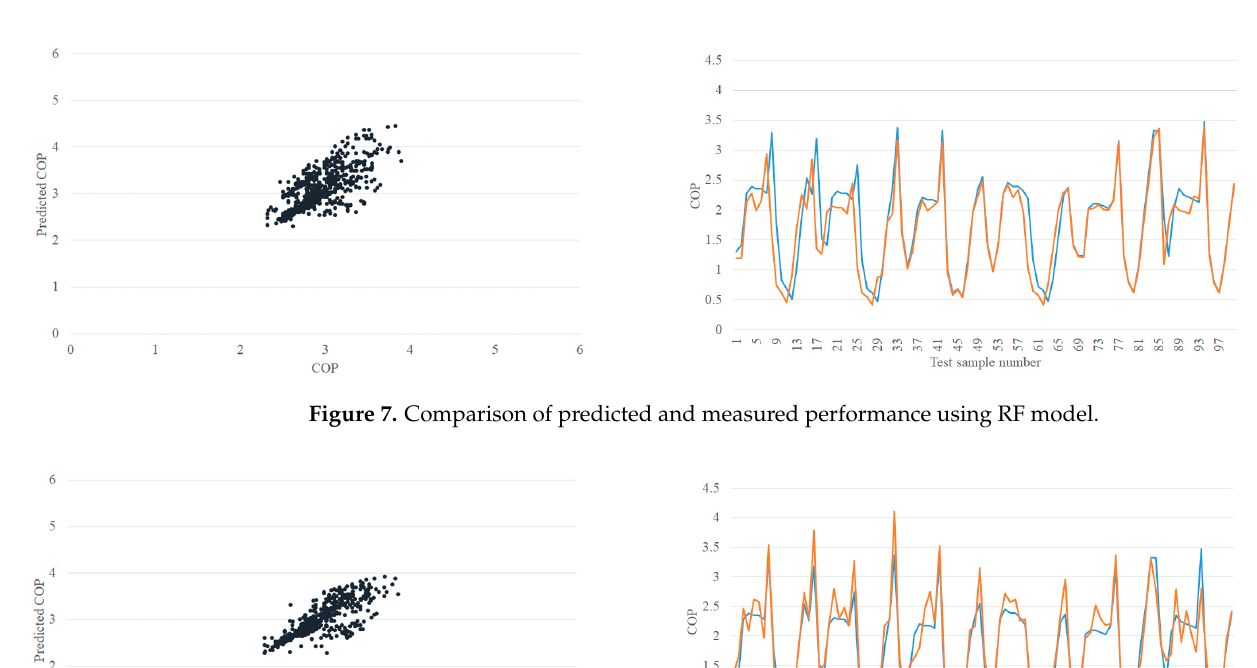
Figure 7. Comparison of predicted and measured performance using RF model.